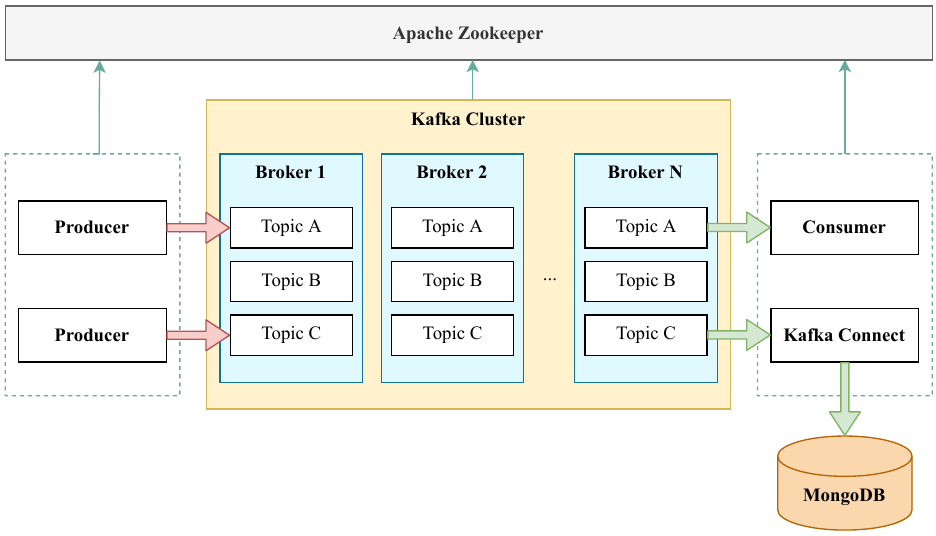
Figure 7. Apache Kafka Ecosystem